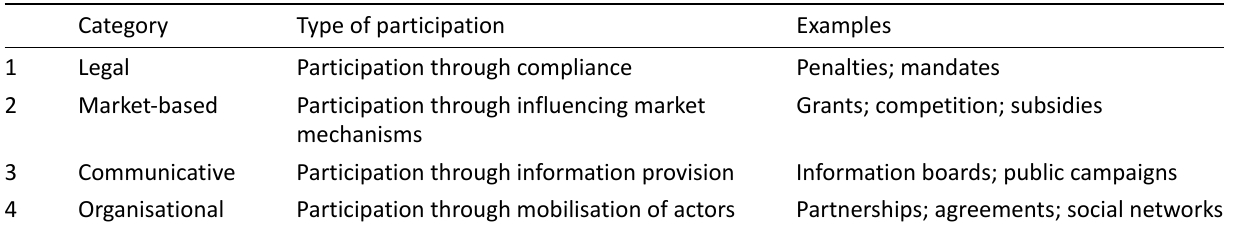
Table 1. Four categories of policy instruments to stimulate participation (adapted from Henstra, 2016; Hood,